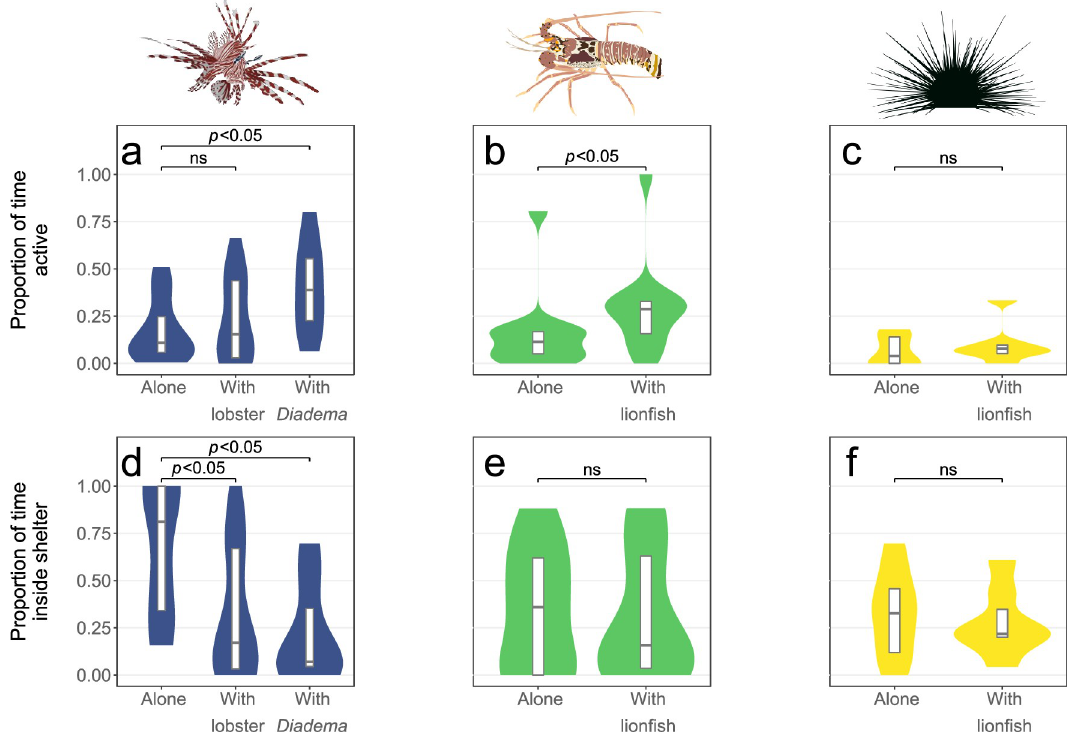
Fig 5. Activity and shelter use of lionfish, lobsters and Diadema . The proportion of time that lionfish, lobsters and Diadema spent active (a,b,c) and inside shelter (d,e,f) in the ‘alone’ and ‘together’ treatments during the 23-hour trial. Each plot represents how the behaviour of the focal species (indicated by the creature image) varies between the ‘alone’ and ‘together’ trials. For the lionfish graphs (a and d), the ‘alone’ bar represents the behaviour of lionfish when alone, the ‘with lobster’ bar represents the behaviour of lionfish in the presence of a lobster, and the ‘with Diadema ’ bar represents the behaviour of lionfish in the presence of a Diadema . For the lobster (b and e) and Diadema (c and f) graphs, the ‘alone’ bar represents their behaviour when alone, whilst the ‘with lionfish’ bar represents their behaviour in the presence of a lionfish. Violin plots represent the spread of the data and are scaled so that the violins on each plot have the same area. Each violin plot is overlaid with a boxplot showing the median and inter-quartile range. All treatments have n = 12, except the ‘lionfish- Diadema together’ treatment, for which n = 7. https://doi.org/10.1371/journal.pone.0236200.g005 that entered the shelter first was also the species that spent the most time inside the shelter (Table 2). However, in the lionfish- Diadema together trials, lionfish and Diadema appeared equally likely to occupy the shelter (dominating the shelter in n = 3 and n = 4 trials respec- tively), even though Diadema always began the trial inside the shelter. Lionfish were 1.9 times more active in the presence of Diadema than when alone (BR, Z = 2.39, p = 0.017; Fig 5) during the 23-hour trial. In contrast, the presence of lobsters had no effect on lionfish activity (BR, Z = 0.487, p = 0.626).Lionfish used shelter 1.9 times more when